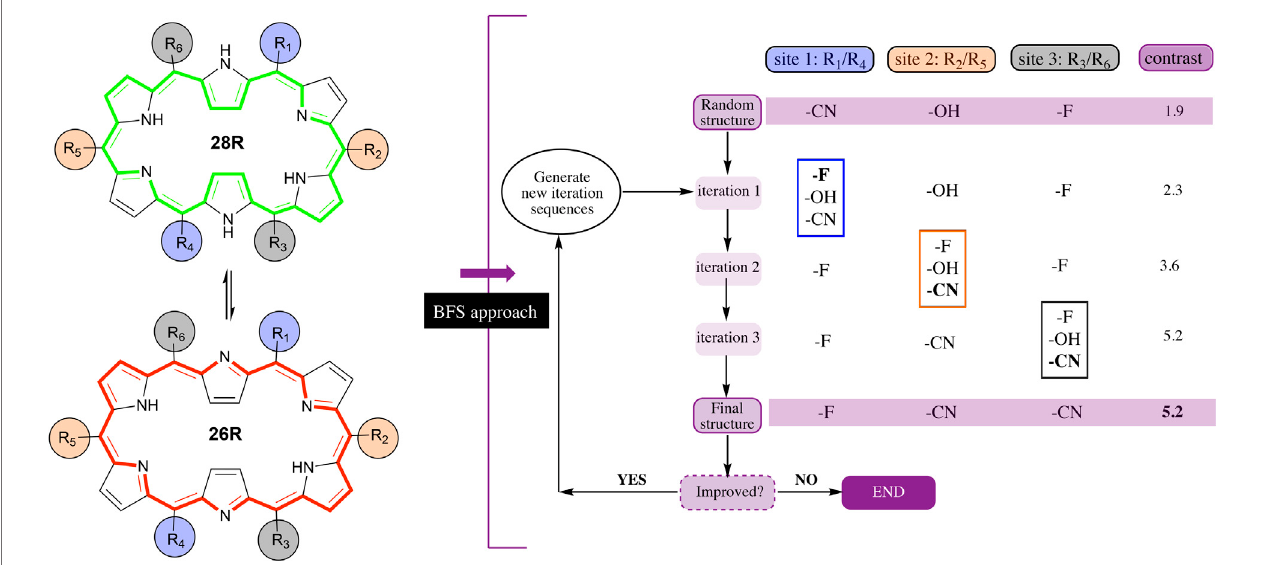
FIGURE 1 | Example of the best- fi rst search algorithm applied on the hexaphyrin-based redox switch ( 26R → 28R ) with six modi fi able sites, considered pairwise, and three substituents. Note that the desired target property, i.e. the NLO contrast, adds to the complexity of the inverse design problem. The contrast optimization requires the evaluation of the fi rst hyperpolarizability of the two states involved in the switching. Thus, for each functionalization, two structure optimizations are needed before evaluating the target property, increasing the computational time. Therefore, the application of an inverse design approach to the discovery of high- performance optical switches remains a challenging